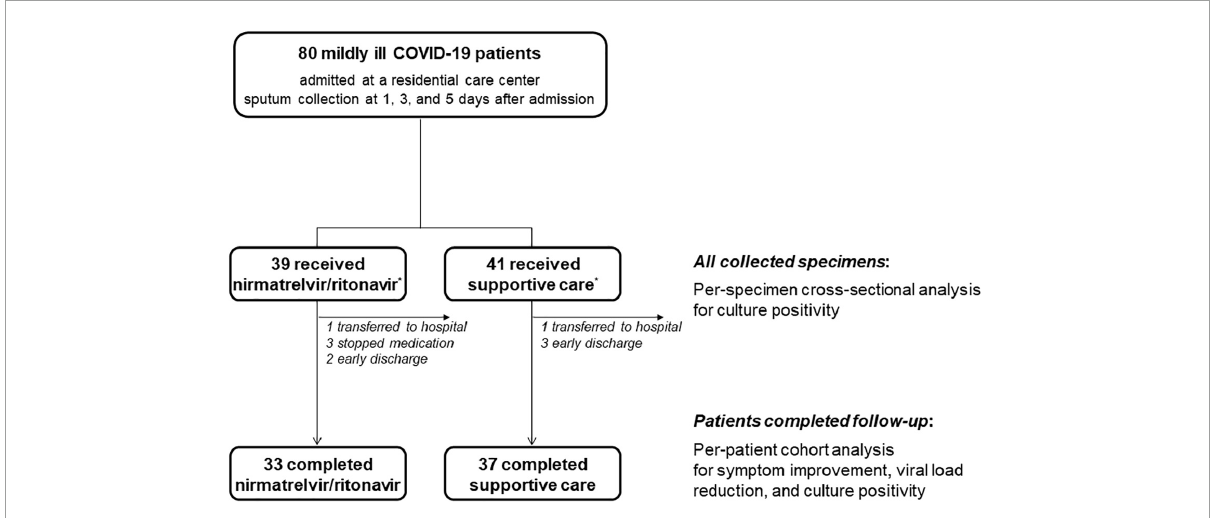
FIGURE1 Schematic flow of patient enrollment and specimen collection. *The target population was 40 patients for each group, but 39 patients who received nirmatrelvir/ritonavir and 41 who underwent supportive care group were finally enrolled due to a labeling error.